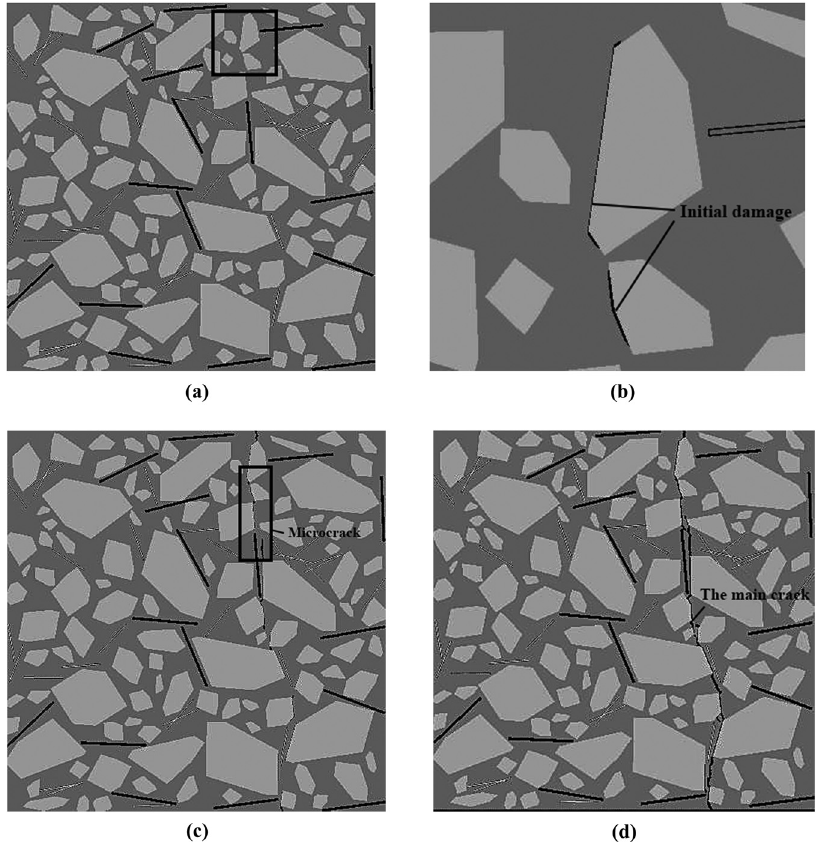
Figure 10: Crack opening process in the steel – polypropylene HFRC. ( a ) initial damage phase ( incremental step 25 ) , ( b ) enlarged view of the initial damage area, ( c ) cracks in expansion ( incremental step 100 ) , and ( d ) fi nal crack morphology ( incremental step 200 )